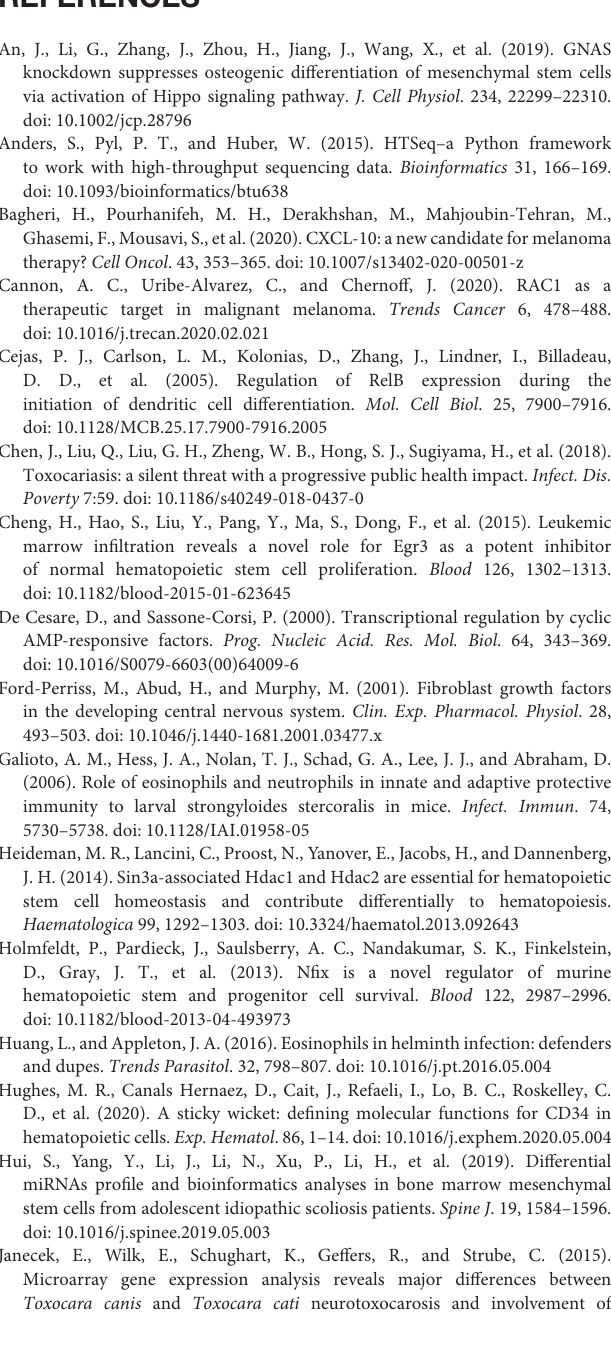
DEmRNAs in the corresponding pathway (bigger dots indicate larger DEmRNA numbers). Supplementary Table 1 | The primers used in the qRT-PCR experiment. Supplementary Table 2 | The differentially expressed lncRNAs and mRNAs at 12 hpi, 24 hpi, 96 hpi, and 36 dpi. Supplementary Table 3 | Co-localization between the differentially expressed lncRNAs and their predicted differentially expressed cis target genes.